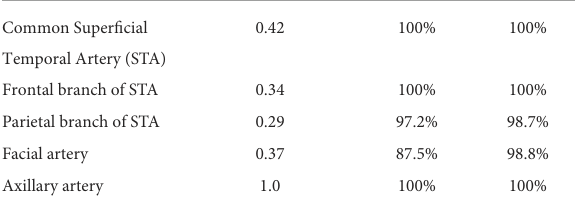
TABLE 1 Cut-off values for distinguishing vasculitic artery from normal artery in suspected cases of GCA with sensitivities and specificities for a clinical diagnosis of GCA